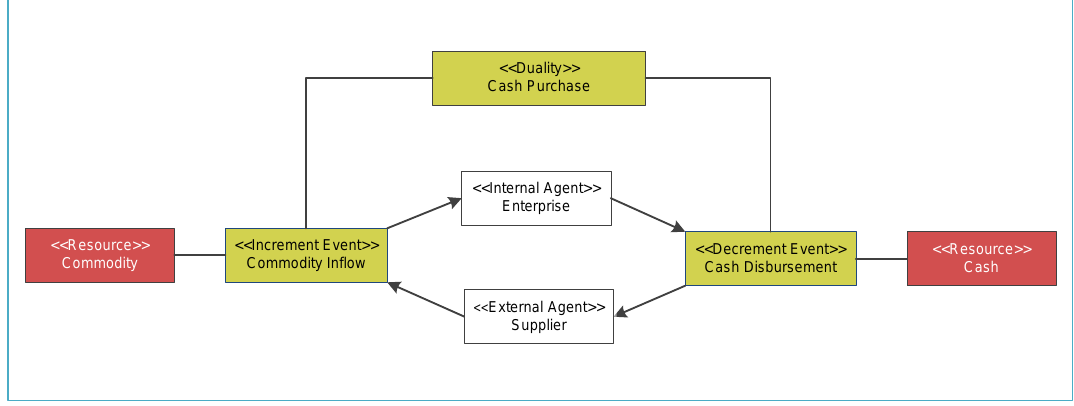
Figure 3 . Duality relationship – cash purchase transaction